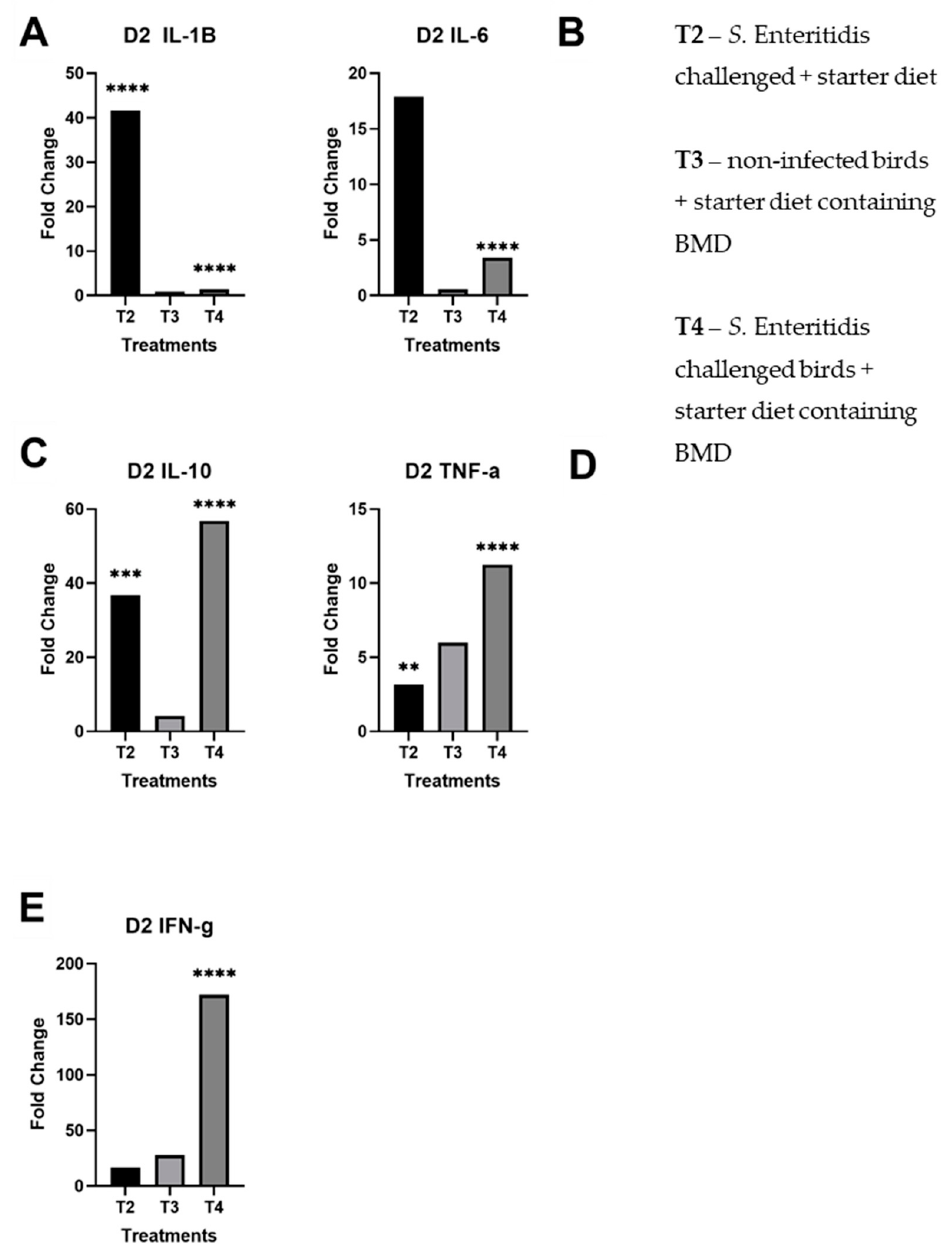
Figure 1. Fold changes of day 2 cecal samples by treatment per panel. These results for each treatment are compared against the control group (T1): ( A ) day 2 fold changes by treatment for IL-1 β ; ( B ) day 2 fold changes by treatment for IL-6; ( C ) day 2 fold changes by treatment for IL-10; ( D ) day 2 fold changes by treatment for TNF- α ; ( E ) day 2 fold changes by treatment for IFN- γ . The starred bars indicate differing levels of significant p -values.